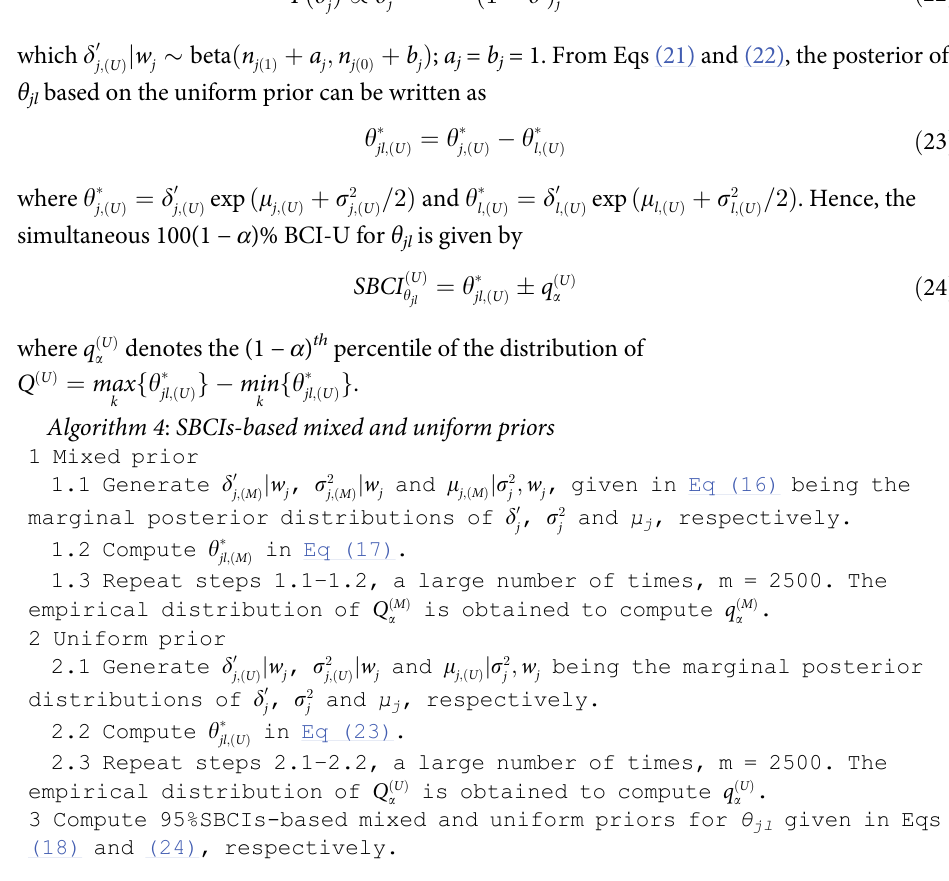
Algorithm 4 : SBCIs-based mixed and uniform